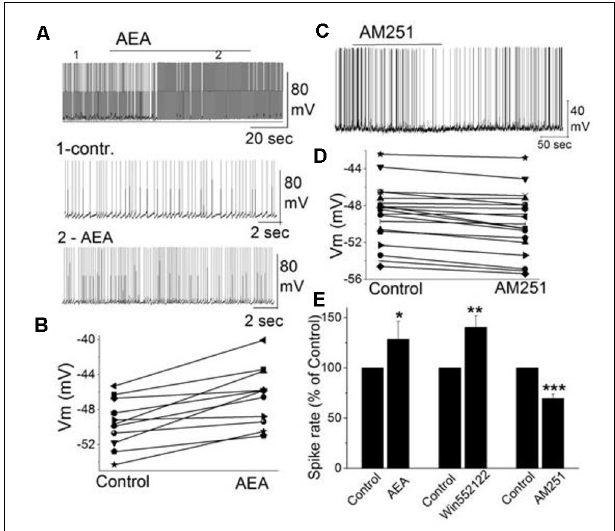
FIGURE 4 | The activity of mitral cells was regulated by cannabinoids. (A) Original recording illustrates the increased firing rate of a mitral cell in response to bath application of CB 1 agonist AEA (10 µ M). Time points 1 and 2 in the upper trace are shown at higher time resolution in the second and third trace, resp. (B) Representative mitral cell depolarized by AEA (10 µ M). (C) Original recording from a mitral cell displayed the reduction in firing